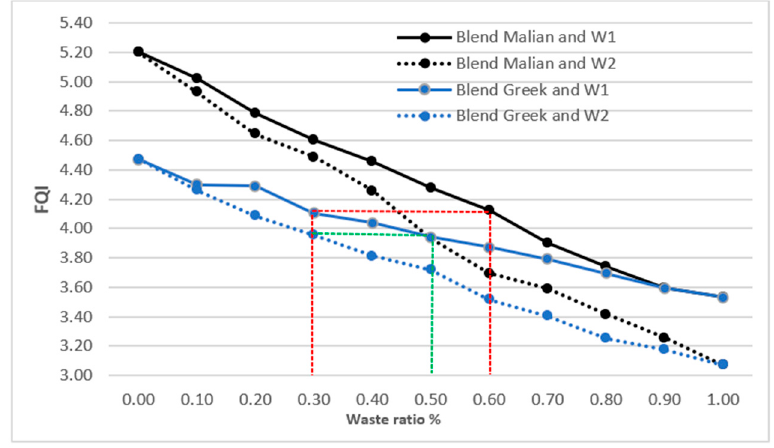
Figure 2. The effect of waste cotton proportion on the blends’ FQI.